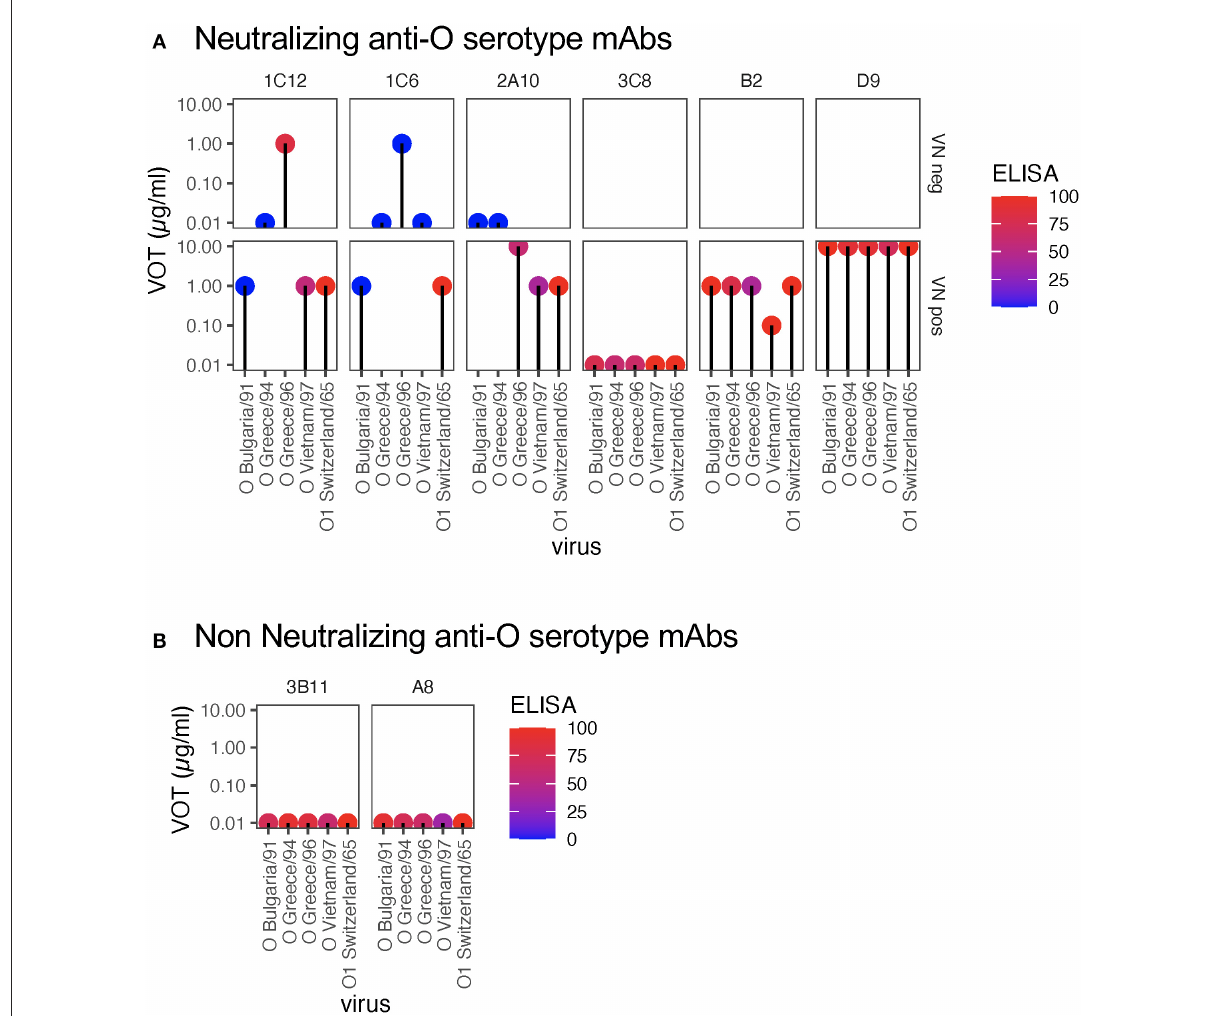
FIGURE1 Virus opsonizing titers of mAbs against serotype O FMDV. VOTs were determined based on RAW264.7 cell death following incubation with mAbs (used at 10, 1, or 0.1 µ g/ml) and virus (5 TCID 50 /cell). For each virus (x-axis), the virus opsonization titres (VOT) are shown by the y-axis levels of the dots. Each plot shows the data for a different mAb (all anti-O serotype, see Table 1). The colors of the dots reflect the ELISA reactivity as indicated in the legend. The panels in (A) show the data for mAbs that neutralize homologous virus. To visualize the relationship of VOT to neutralization, the data was separated by the ability of a specific mAb to neutralize the different O FMDV viruses. The upper panels show the VOT data for mAb-virus pairs without neutralization (“VN neg”), while the lower panels represent mAb-virus pairs with neutralization (“VN pos”). In (B) , the data for mAbs with no neutralizing activity against homologous virus are